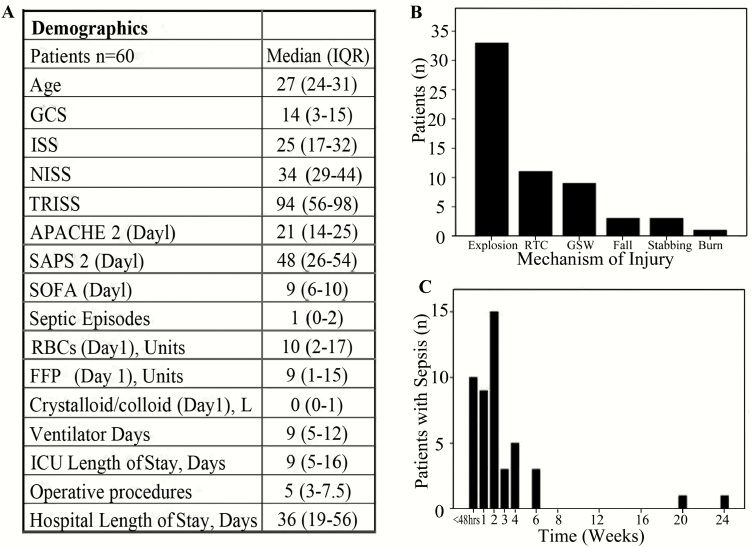
Patient characteristics of the analysis cohort. A, Demographics. B, Mechanism of injury. C, The distribution of septic episodes for 60 male survivors from severe injury (NISS > 15) under 50 years of age.